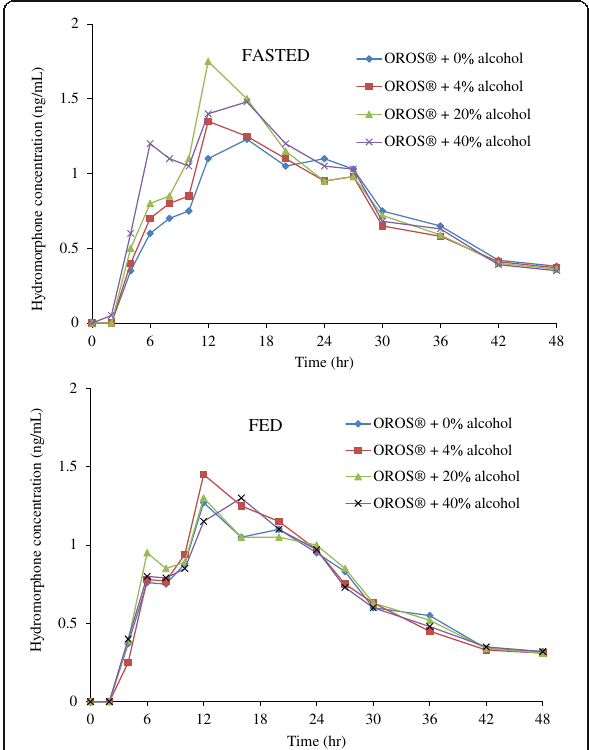
Fig. 1 Mean hydromorphone plasma concentration profiles (data from